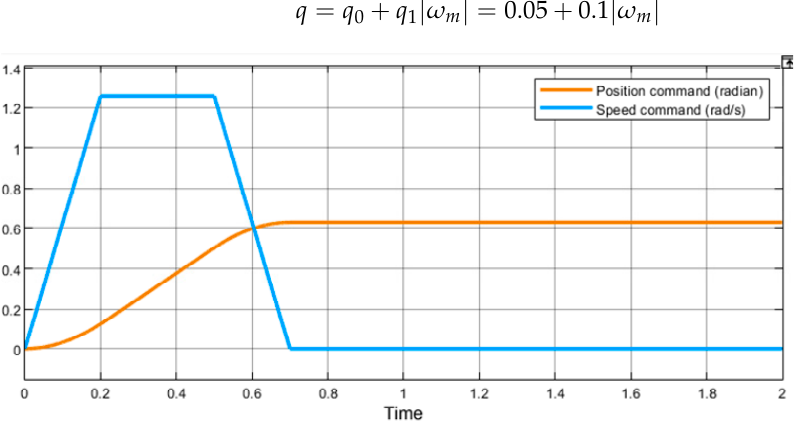
Figure 4. The position command and speed command profiles.